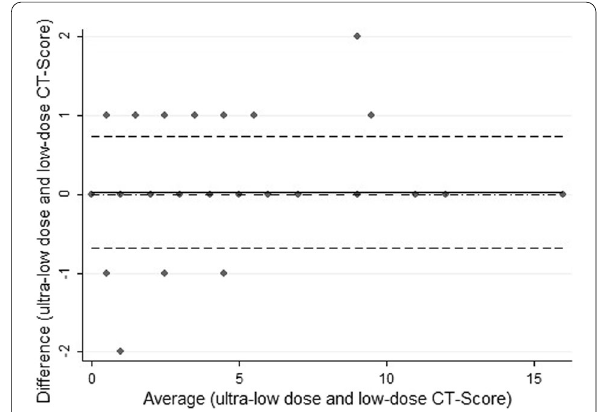
Fig. 4 Bland–Altman plot of difference in CT score (ultra‑low‑dose score minus low‑dose CT score) against the mean score of the two methods; cases over limit 10 (5.99%); cases under limit 6 (3.59%) = =